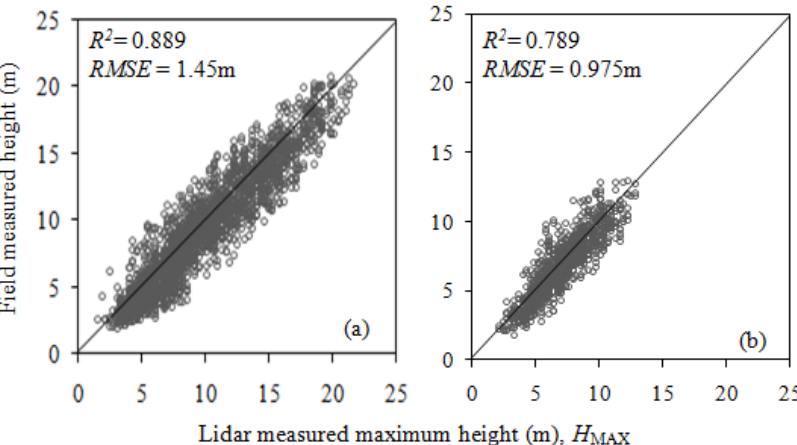
Figure 4. Relationship between field-measured height and lidar-measured maximum height in ( a ) broadleaf trees (total 2292 trees) and ( b ) conifers (total 1058 trees).